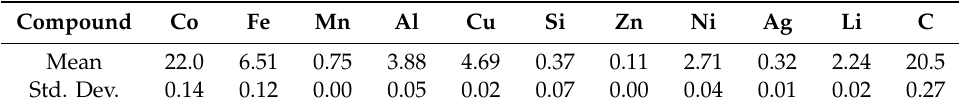
Table 1. Composition of the black mass in wt.% analyzed by ICP-OES and combustion.